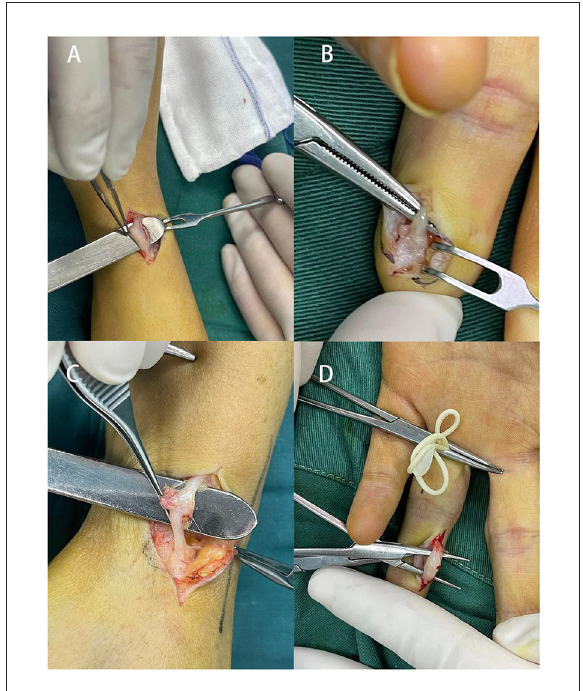
FIGURE2 Cases of surgical management in four patients suffering from traumatic neuromas. (A) A 32-year-old female patient with a 2-year history of painful mass on the radial side of the right wrist; (B) a traumatic neuroma of the middle finger in a 34-year-old female patient as a result of previous finger tope amputation, (C) a 24-year-old patient with a traumatic neuroma on the wrist, (D) 33-year-old female presented a left index finger traumatic neuroma with local radiation pain for half a month, the patient had a history of left index finger injury by scissors several years